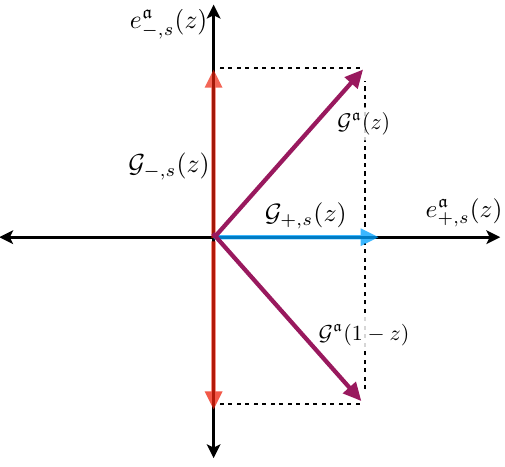
e a G a ( z ) sepatate out as crossing ± ,s a